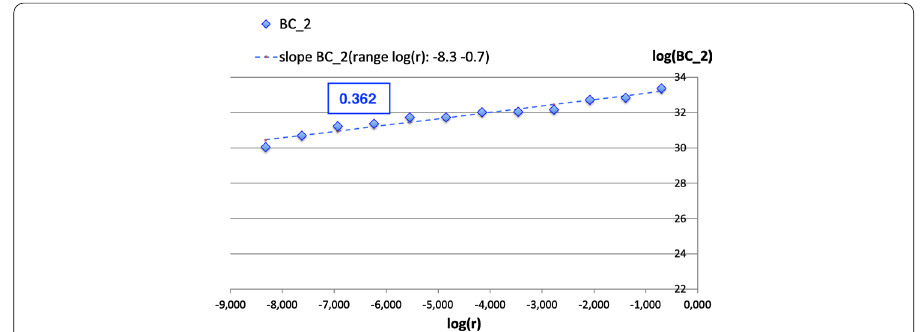
Fig. 6 Example of box-counting plots ( BC 2 r ( D , long ) ) for the context attribute representing the longitude with q =